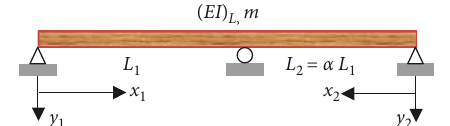
Figure 7: A continuous timber floor beam with two unequal spans and pinned-pinned end